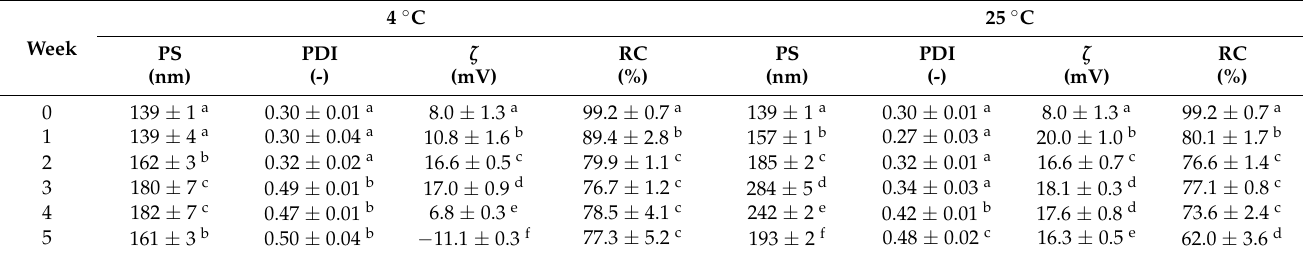
Table 3. Evolution of PS, PDI, ζ and residual content of TEO-CSNC during storage at 4 and 25 ◦ C. 4 ◦ C 25 ◦ Week